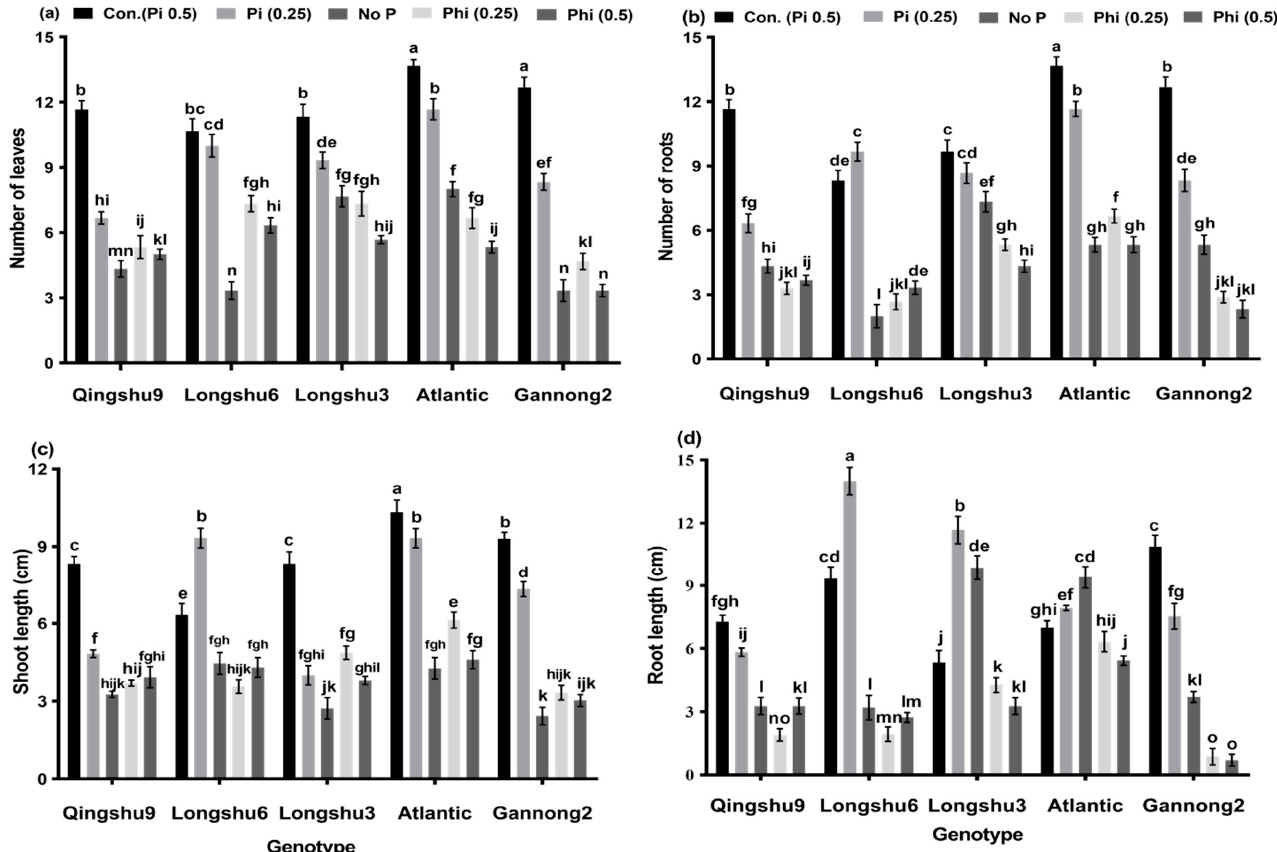
Figure 1. Effect of Phi, Pi and No-P on ( a ) number of leaves, ( b ) number of roots, ( c ) shoot length (cm), and ( d ) root length (cm) of five potato genotypes grown in modified MS media containing 0.25 and 0.5 mM Phi and Pi and No-P supply for 20 days. Values denote the mean of 3 replicates, ±standard deviation (SD). Means obtained with the same letter in the minuscule do not differ by Duncan Multiple range’s test ( p ≤ 0.05). Table 1. Effect of Phi, Pi and No-P supply on fresh biomass, root/shoot ratio and biomass tolerance index of five potato genotypes studied under in vitro conditions.